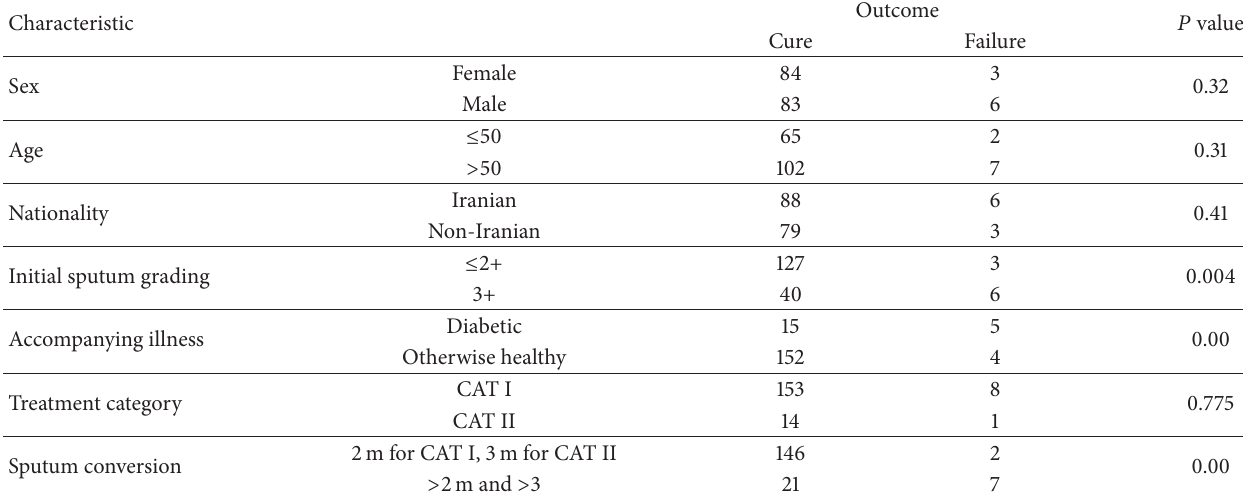
Table 4: Impact of comorbidity and demographic, microbiological, and therapeutic variables on failure. Characteristic